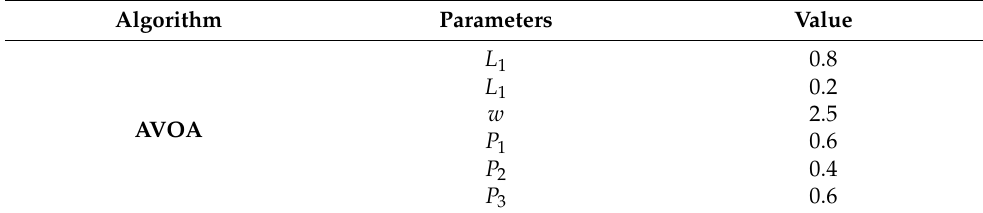
Table 2. The AVOA algorithm parameters.